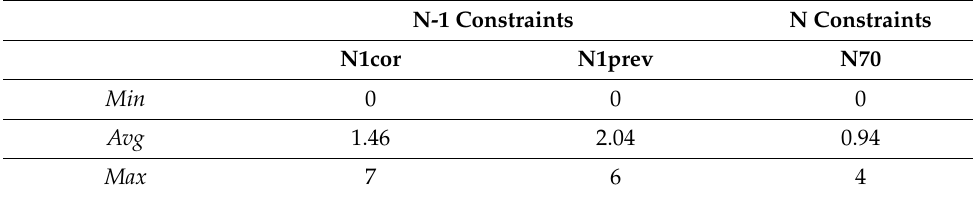
Figure 12. Congestions identified by N-1 security constraints. Table 4. Congestion activation statistics: number of congestions active per case.